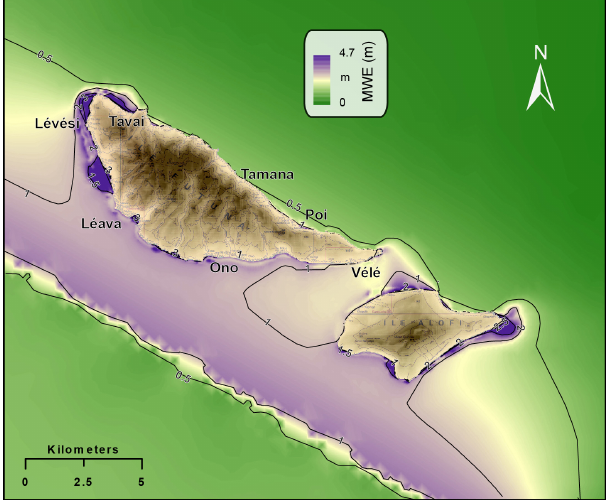
Figure 15. Maximum wave elevation (in m) at Futuna and Alofi generated from a local M W = 7 earthquake along the Futuna Trans- form Fault (Sc. 15, Table 4, Fig.